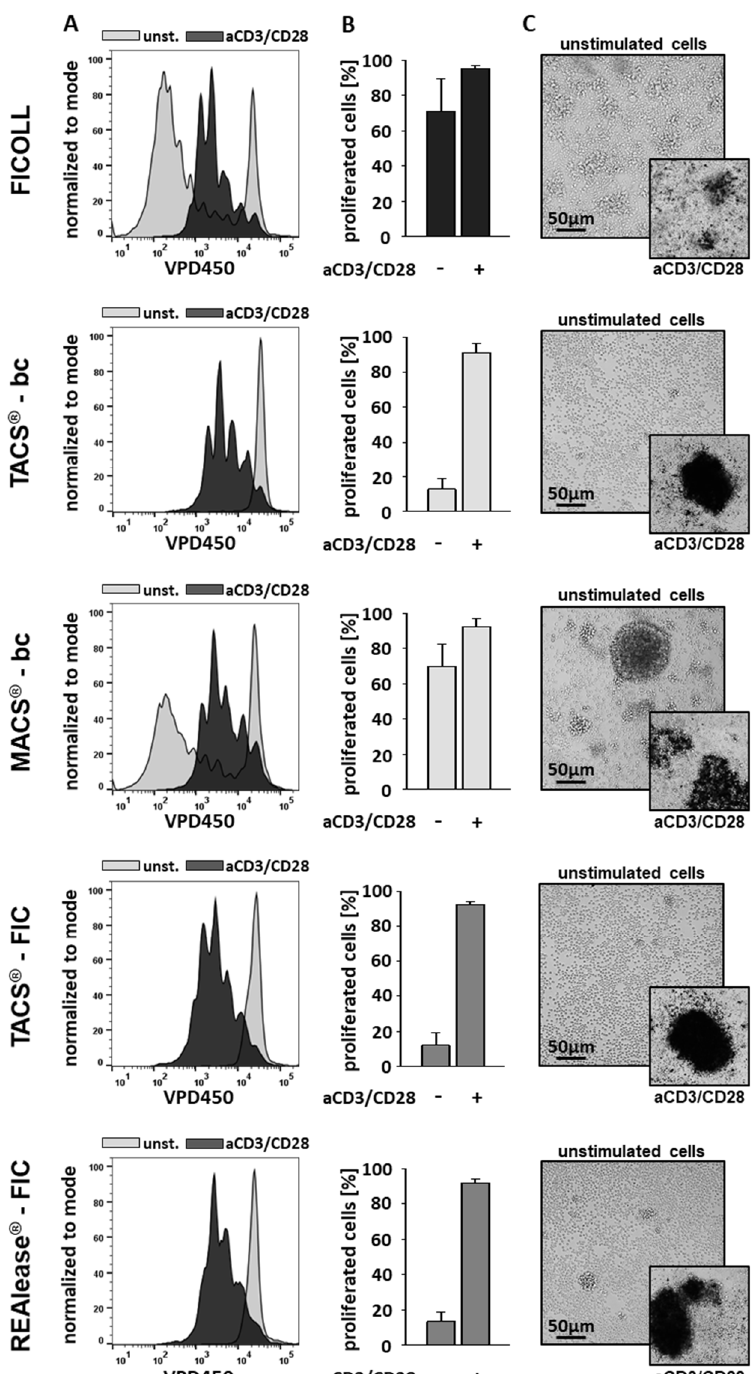
Figure 5. Effect of the different CD3 − dependent isolation methods on cell morphology and proliferation. After separation, cells were labeled with VPD450 and cultured (1 × 10 6 /mL) in the presence or absence of Dynabeads™ Human T-Activator CD3/CD28 at a bead-to-cell ratio of 3:1 (anti CD3/CD28 stimulation (aCD3/CD28)). After 6 days the lymphocyte proliferation was analyzed by flow cytometry. Representative histogram overlays show the discrimination strategy between proliferating (aCD3/CD28) and non-proliferating (unst.) lymphocytes ( A ). The results ( n = 4) are represented as the mean ± SD of the proliferating CD3-positive lymphocytes ( B ). The morphology of the stimulated (aCD3/CD28) and unstimulated cells was examined using brightfield microscopy ( C ). Shown is one representative experiment out of four.